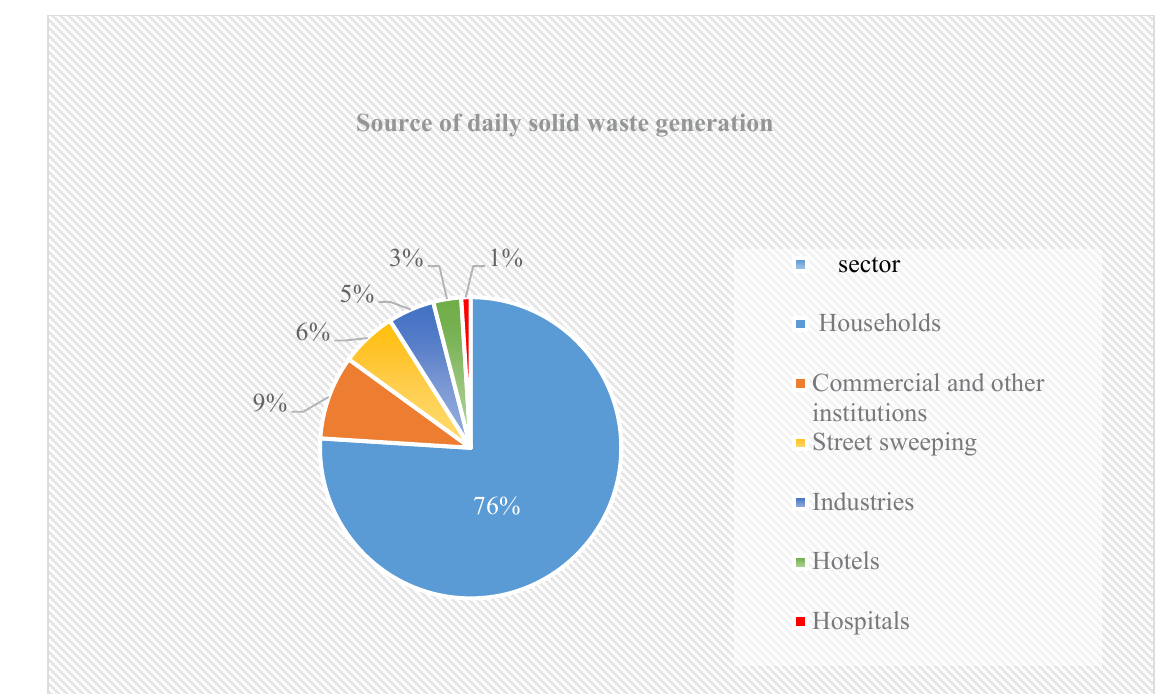
Figure 3. Source of Dry Waste Production Per Day